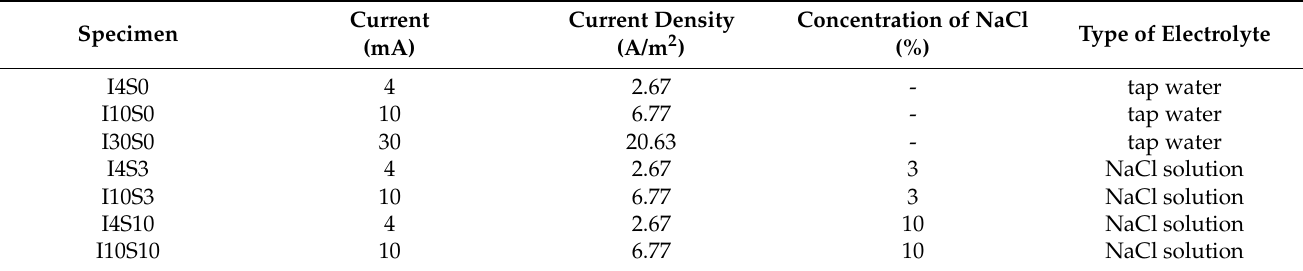
Table 2. The details of experimental